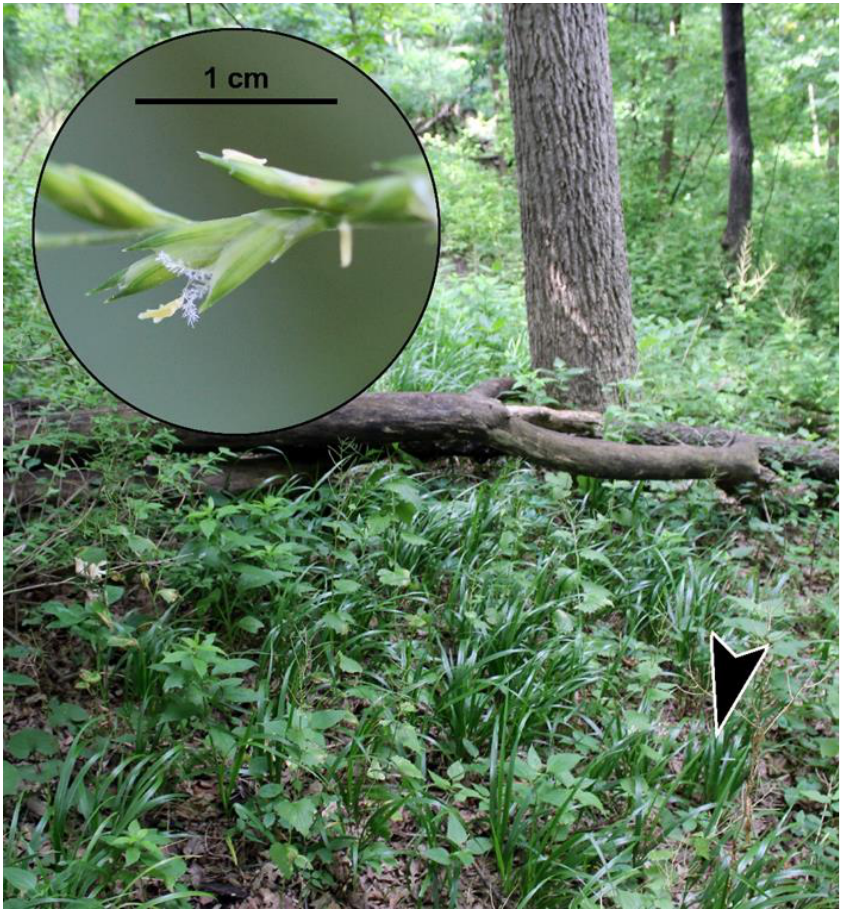
Figure 1. A slope of deciduous forest in Ames, IA with plants of Diarrhena obovata indicated by an arrowhead and a view of spikelets shown in the